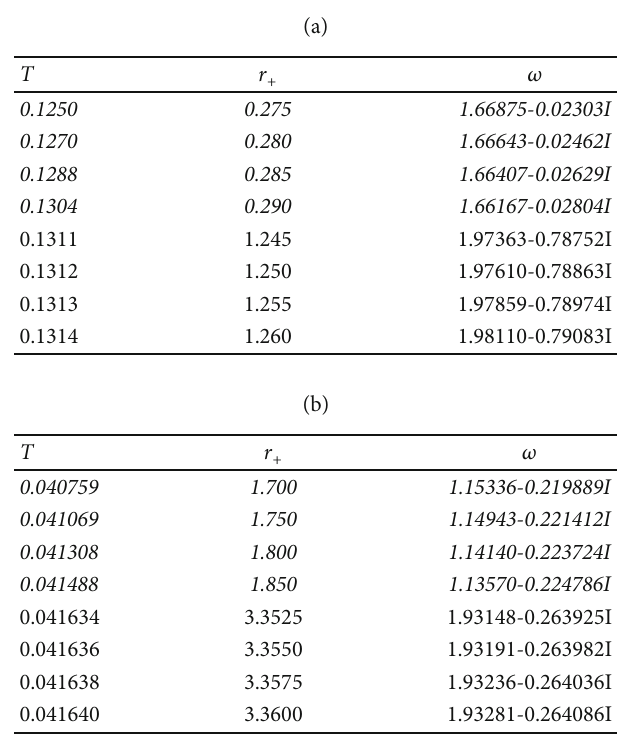
Table 2: The QNM frequencies of (a) ( ω with the change of temperature T and horizon radius r + . The italic values denote the small black hole phase, while the rest of the values correspond to the large black hole